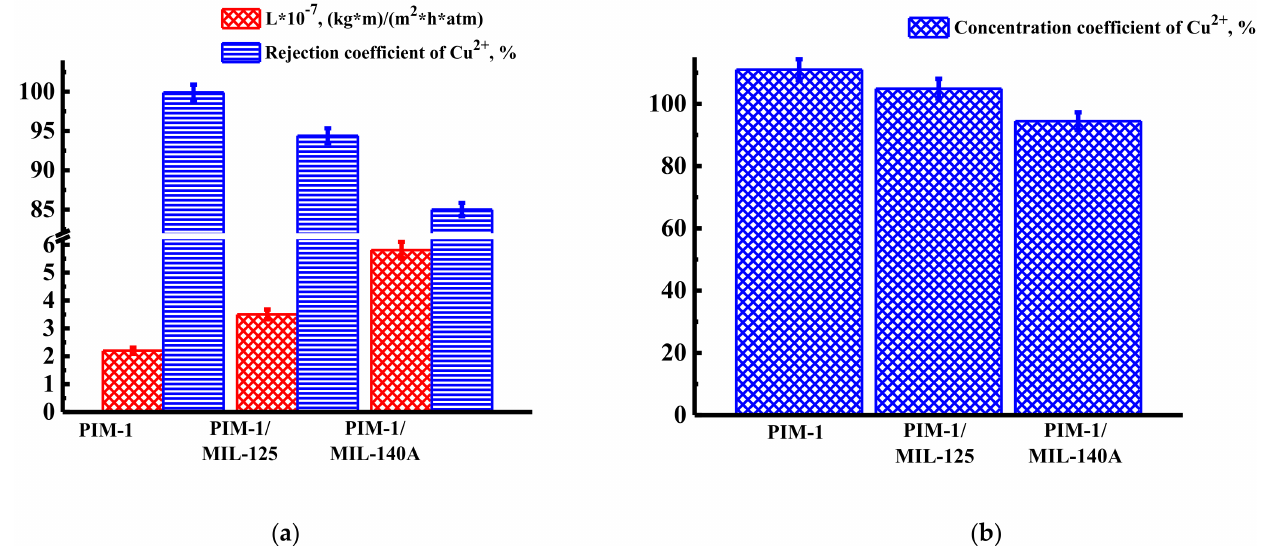
Figure 4. Transport properties: ( a ) permeability and rejection coefficient and ( b ) concentration coefficient during nanofiltration of the solution containing copper ions (Cu 2+ ) at 50